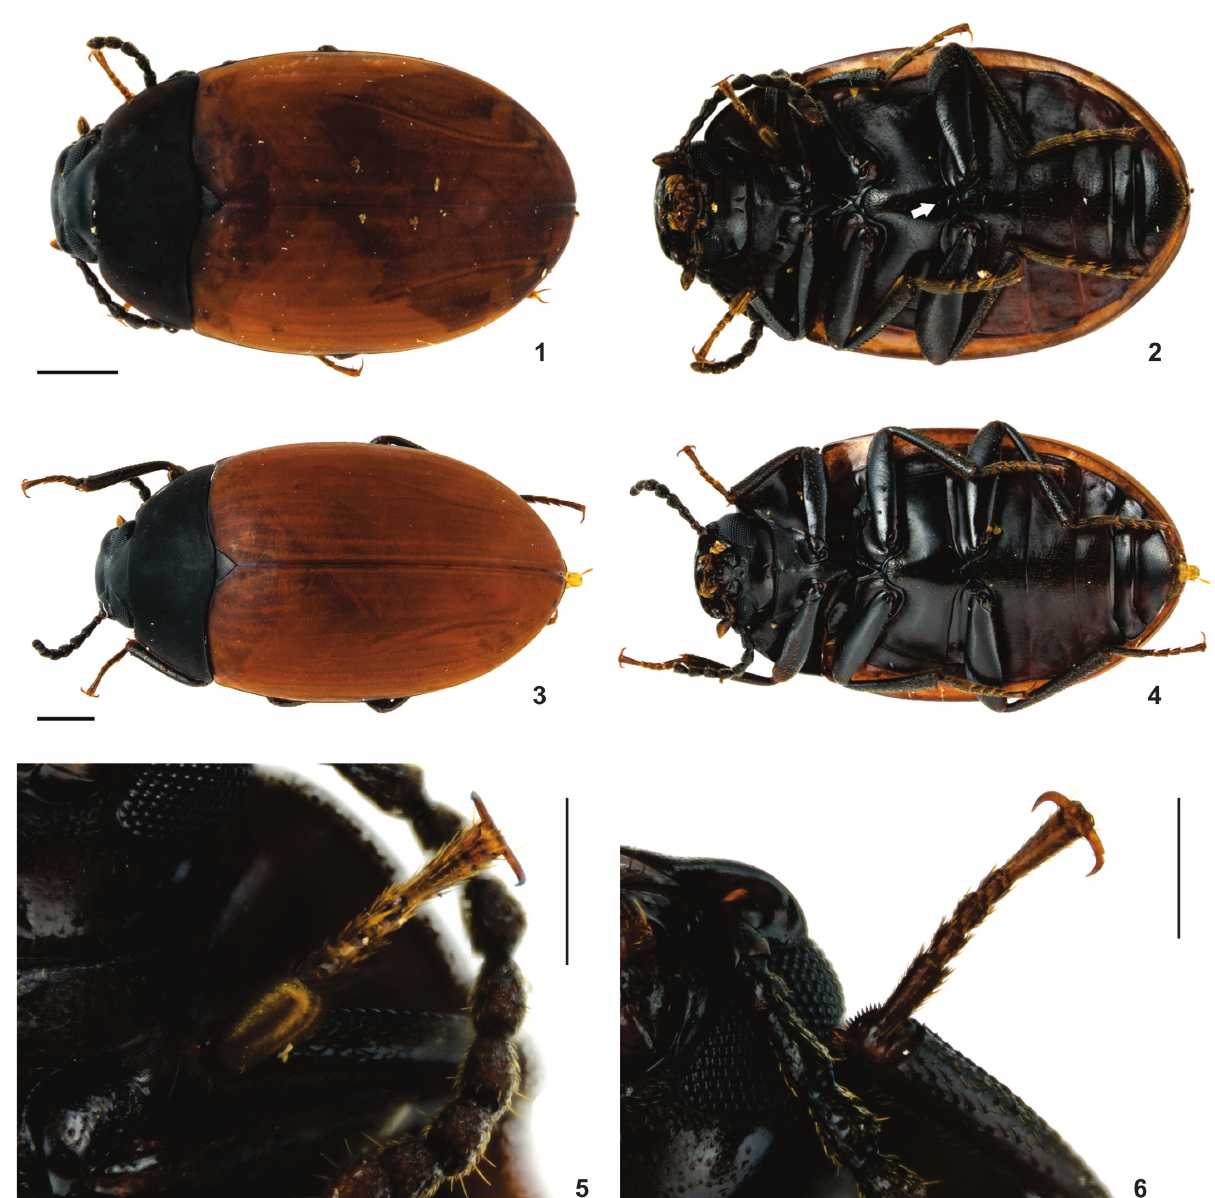
Figures 1–6. Lelegeis pytanga sp. nov.: male holotype, habitus dorsal (1) and ventral (2) views. Female paratype, habitus dorsal (3) and ventral (4) views. Protarsomeres male (5) and female (6). Scale bars: 1–4 = 1 mm, 5–6 = 0.5 mm. twice as long as the basal ones; each apical gonocoxite small, about as long as the basal, bearing long setae and one long gonostylus; gonostyli inserted almost laterally, about as long as apical gonocoxites, slightly expanding to apex, apex bearing five long setae; paraprocts about as long as gonocoxites together, bearing long parallel baculi. Proctiger long, slender, medially membranous, bearing baculi